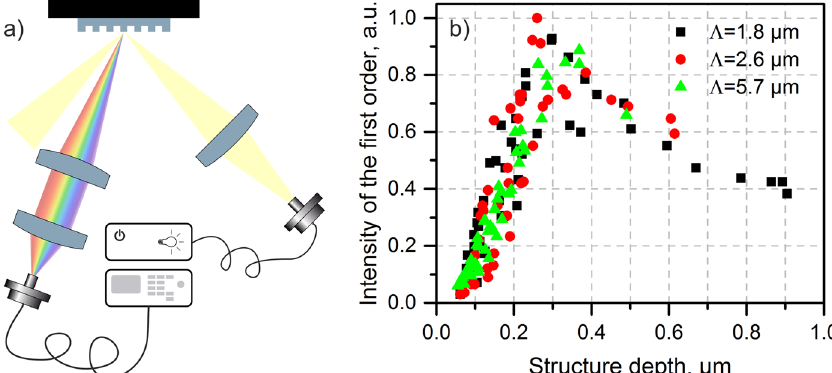
Figure 4. ( a ) Setup of the spectroscopic device used to measure the intensity of the first order diffraction efficiency and ( b ) measured first diffraction order intensity for the hole-like periodic patterns with 1.8 µ m, 2.6 µ m and 5.7 µ m spatial periods. The maximal measured intensity was obtained for a structure depth of approximately 0.3 µ m for all